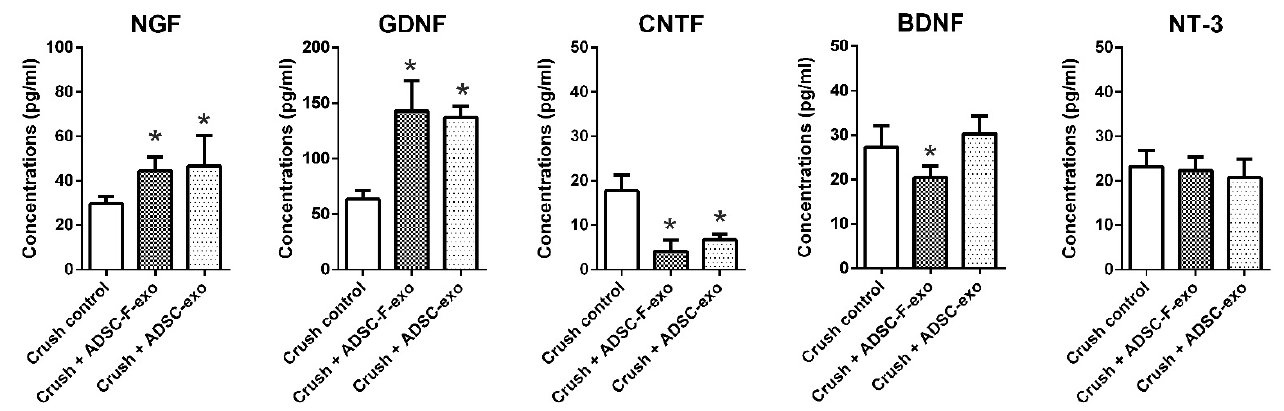
Figure 5. Neurotrophin levels in nerve segments after exosome treatment determined by enzyme-linked immunosorbent assay. Statistical analysis was performed by one-way analysis of variance with a post-hoc Fisher’s least significant difference test. * indicated a statistical significance which was set at p < 0.05.